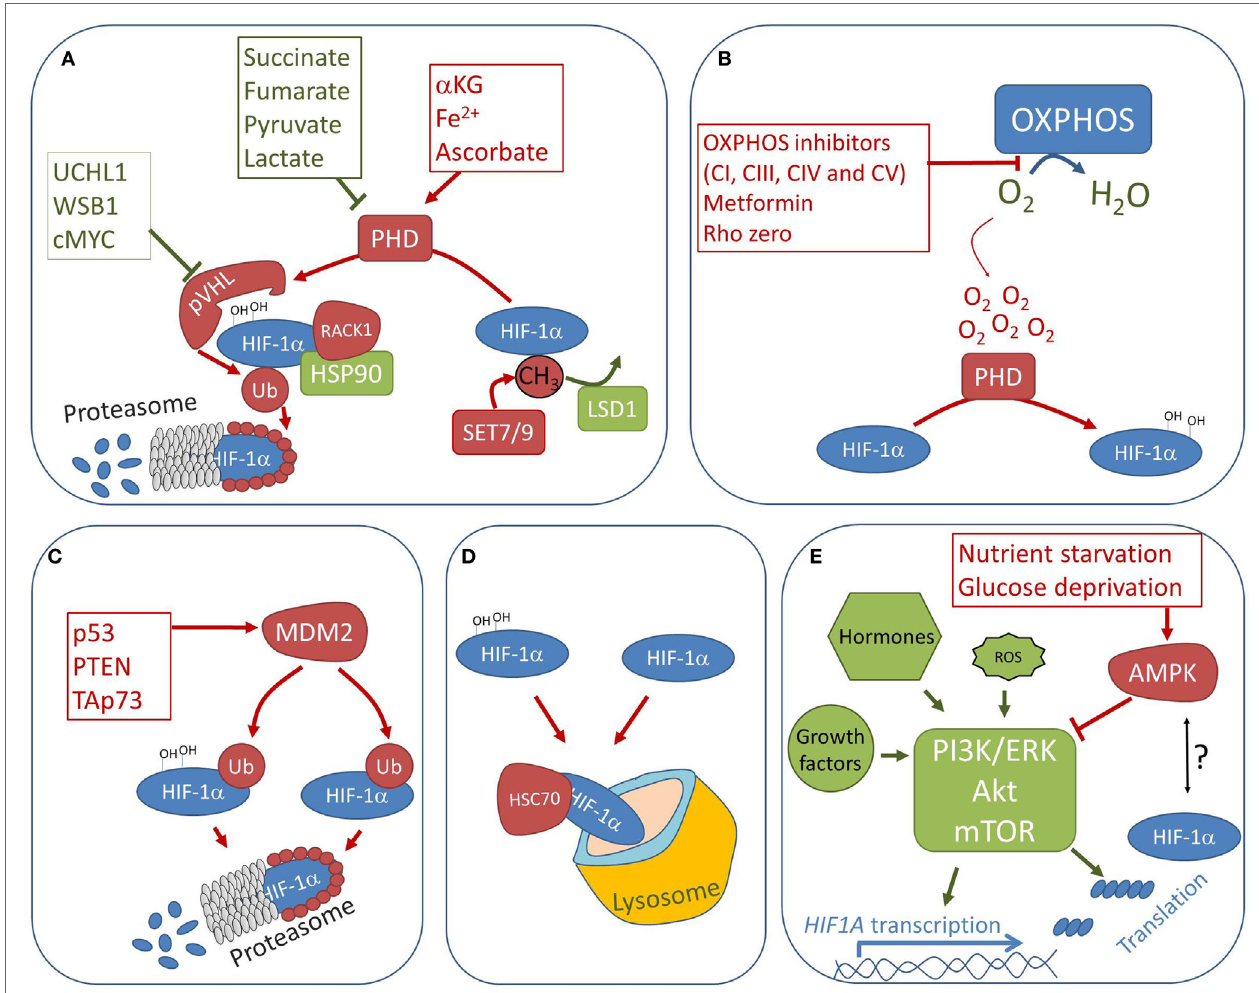
FiGURe 2 | Non-canonical regulation of HIF-1 α stability. Factors promoting pseudonormoxia and pseudohypoxia are indicated in red and green, respectively. (A) Prolyl hydroxylase (PHD) activity may be blocked by accumulation of Krebs cycle metabolites succinate and fumarate, whereas α KG, and co-factors ascorbate and iron, boost PHDs activity regardless of oxygen levels. Activation of any factor promoting pVHL downregulation in normoxia will also lead to pseudohypoxic stabilization of HIF-1 α . Finally, posttranslational modifications, such as methylation by SET7/9, or interactions with proteins, such as receptor of activated protein C kinase (RACK1) and HSP90, may regulate PHD accessibility to HIF-1 α and promote or block hydroxylation regardless of oxygen concentrations. (B) Severe damage or inhibition of oxidative phosphorylation (OXPHOS) complexes I, III, IV, or V, reduces oxygen consumption, which in turn may increase intracellular oxygen concentrations and cause pseudonormoxia. (C) MDM2 is an ubiquitine ligase, which promotes HIF-1 α degradation in hypoxic environment when associated with tumor suppressor proteins. (D) Proteasome-independent HIF-1 α degradation via chaperone-mediated autophagy is mediated by HSC70. (e) PI3K/Akt/mTOR axis is the major pathway involved in promoting HIF1A transcription and translation, regardless of oxygen concentrations and upon numerous protumorigenic stimuli. For example, elevated reactive oxygen species concentrations were shown to promote HIF1A transcription and translation via Akt signaling. On the other hand, conditions counteracting mTOR pathway, such as nutrient starvation, and possibly adenosine monophosphate kinase (AMPK) activation, may lead to HIF-1 α